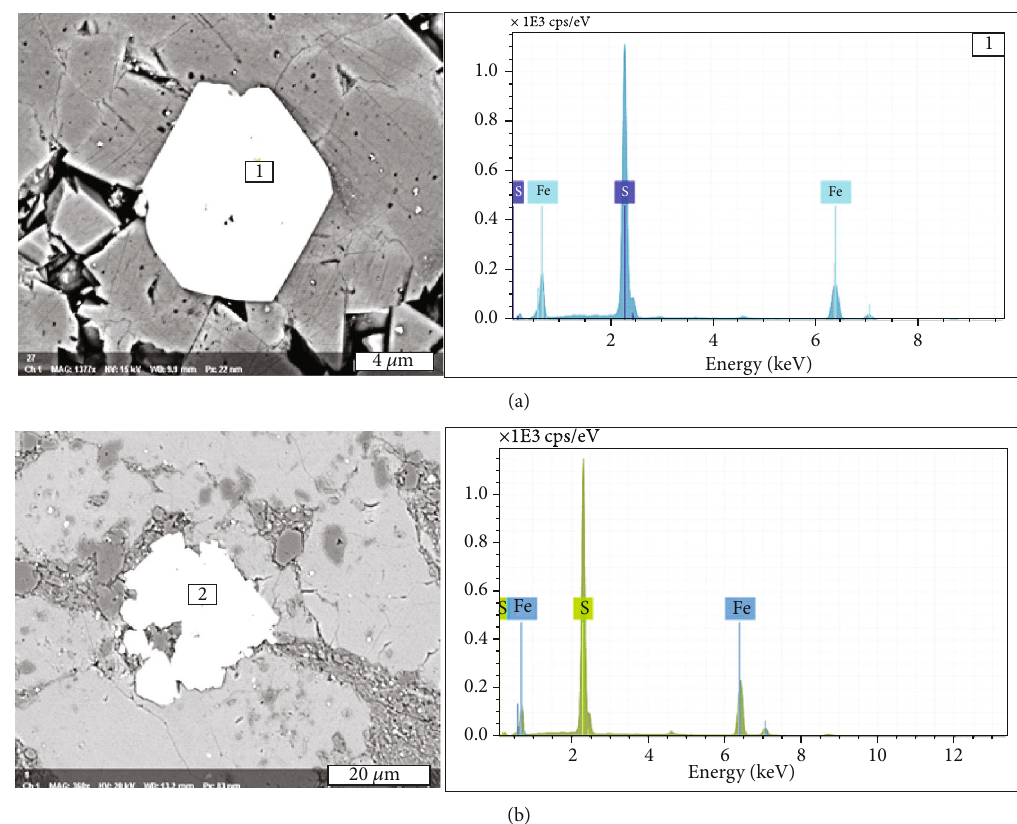
Figure 5: SEM and EDS analysis results of pyrite in Yican 1 well of the southeastern Ordos Basin. (a) Cubic pyrite in Yican 1 well, 2646.64m, Ma 51 . (b) Pyrite assemblage in Yican 1 well, 2684.86m, Ma 54 .